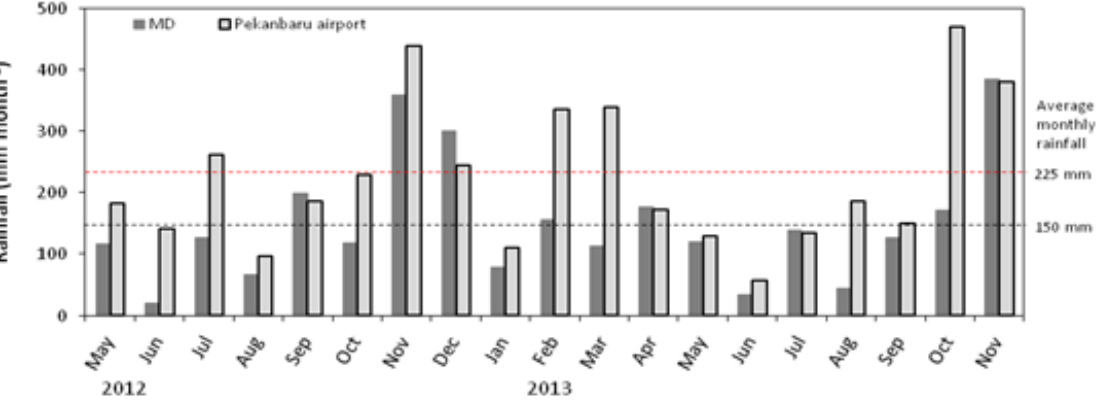
Figure 2. Monthly rainfall at the Meranti Ditch (MD) study site and Pekanbaru Airport, May 2012 to November 2013.